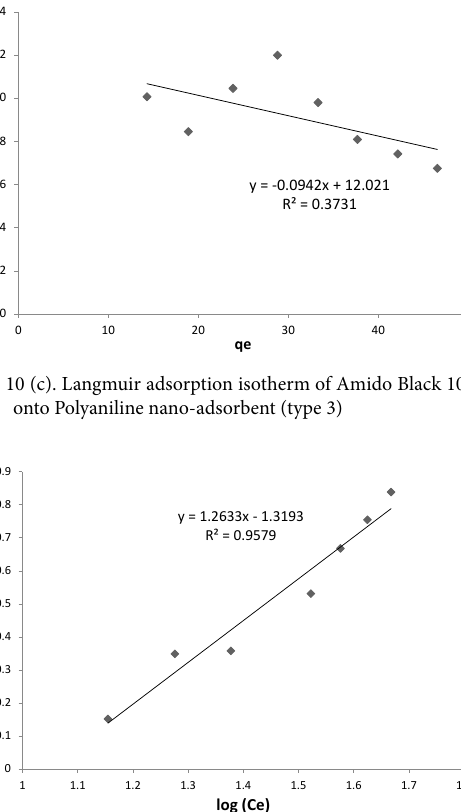
Fig. 10 (a). Langmuir adsorption isotherm of Amido Black 10B onto Polyaniline nano-adsorbent (type 1) Fig. 10 (b). Langmuir adsorption isotherm of Amido Black 10B onto Polyaniline nano-adsorbent (type 2)